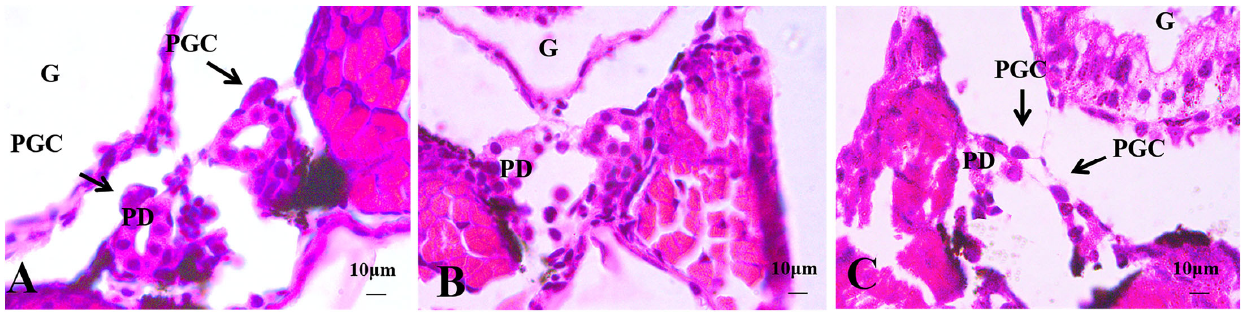
Figure 2. Histological images of gonads of loaches at 4 days post ‐ hatching (dph). ( A ): diploid loach; ( B ): hybrid triploid loach without gonads; ( C ): hybrid triploid loach; G: digestive tract; PGC: primordial germ cell; PD: anterior renal duct).